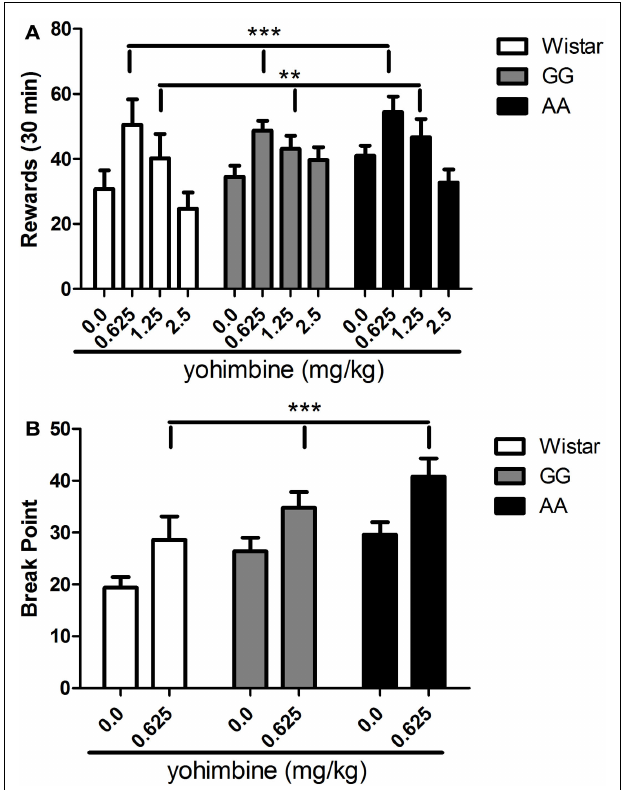
FIGURE 3 | (A) Dose-response curve of antalarmin (0, 5, 10, 20mg/kg) when systemically (i.p.) injected inWistar ( n = 7), as well as GG ( n = 12), and AA ( n = 14) msP rats as assessed on operant alcohol self-administration on a fixed ratio 3 (FR-3) schedule of reinforcement.The AA msP rat line shows increased sensitivity to antalarmin treatment compared to the other rat line examined. Data are the mean ( ± SEM) number of rewards earned in 30min. ** p < 0.01, difference from the vehicle-treated groups (0mg/kg). (B) I.p. pre-treatment with antalarmin (10mg/kg) fully blocks the escalation of alcohol self-administration (FR-3) elicited by systemic (i.p.) treatment with yohimbine at the dose of 0.625mg/kg in all rat lines examined [Wistar ( n = 8), as well as GG ( n = 10) and AA ( n = 15) msP rats]. Results are the mean ( ± SEM) number of rewards earned in 30min. *** p < 0.001, difference from the groups receiving both vehicle-treatments of antalarmin and yohimbine ( − / − ); ### p < 0.001, difference from the groups receiving yohimbine 0.625mg/kg ( ± ).Wistar: white bars; GG: gray bars; AA: black bars. For detailed statistics, see “Results.”